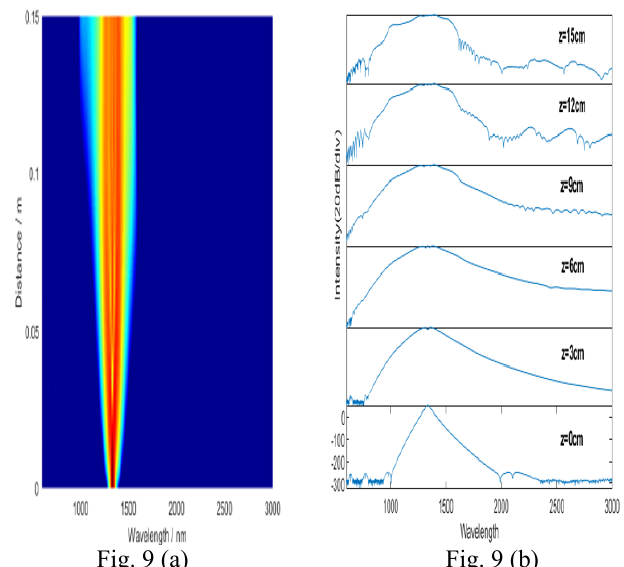
Figure 9: Density plot of spectral profile Fig. 9 (a) and Spectral profile Fig. 9(b) of supercontinuum generation of a 15cm long silica PCF at peak power of 1kW with pulses of 50fs duration